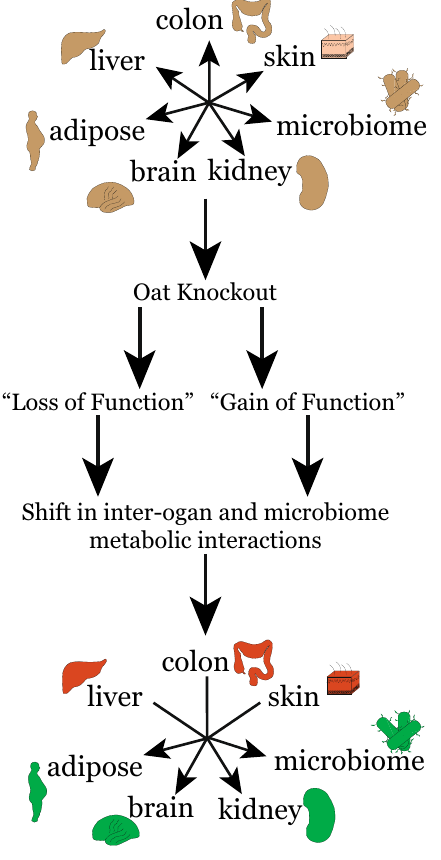
Figure 11. OAT KO loss and gain of function. The constraint on cellular small metabolite transport capabilities due knockout of Oat1 or Oat3 can indirectly lead to apparent ‘gain of functions’ via altered substrate